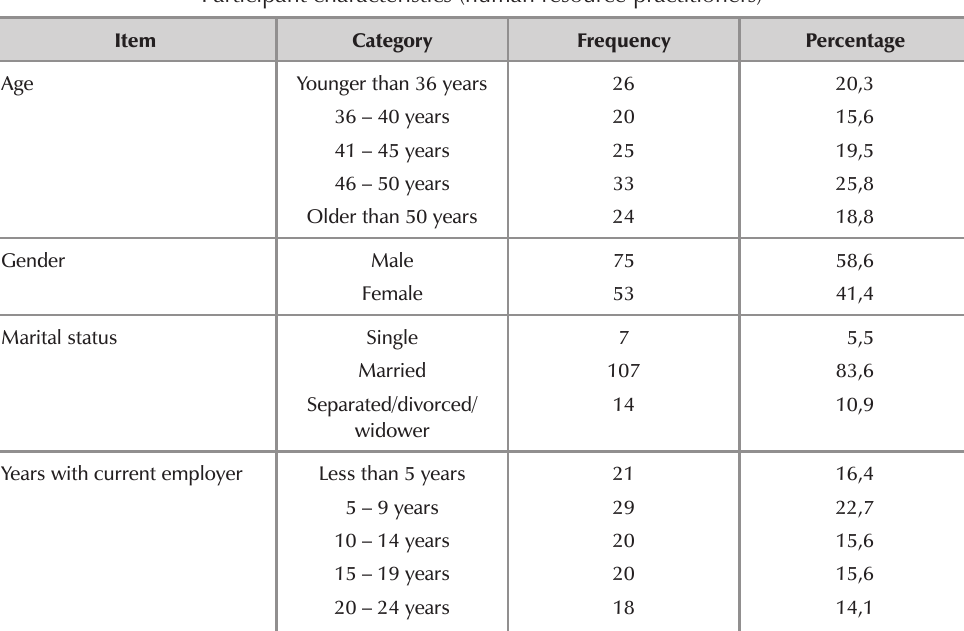
Participant characteristics (human resource